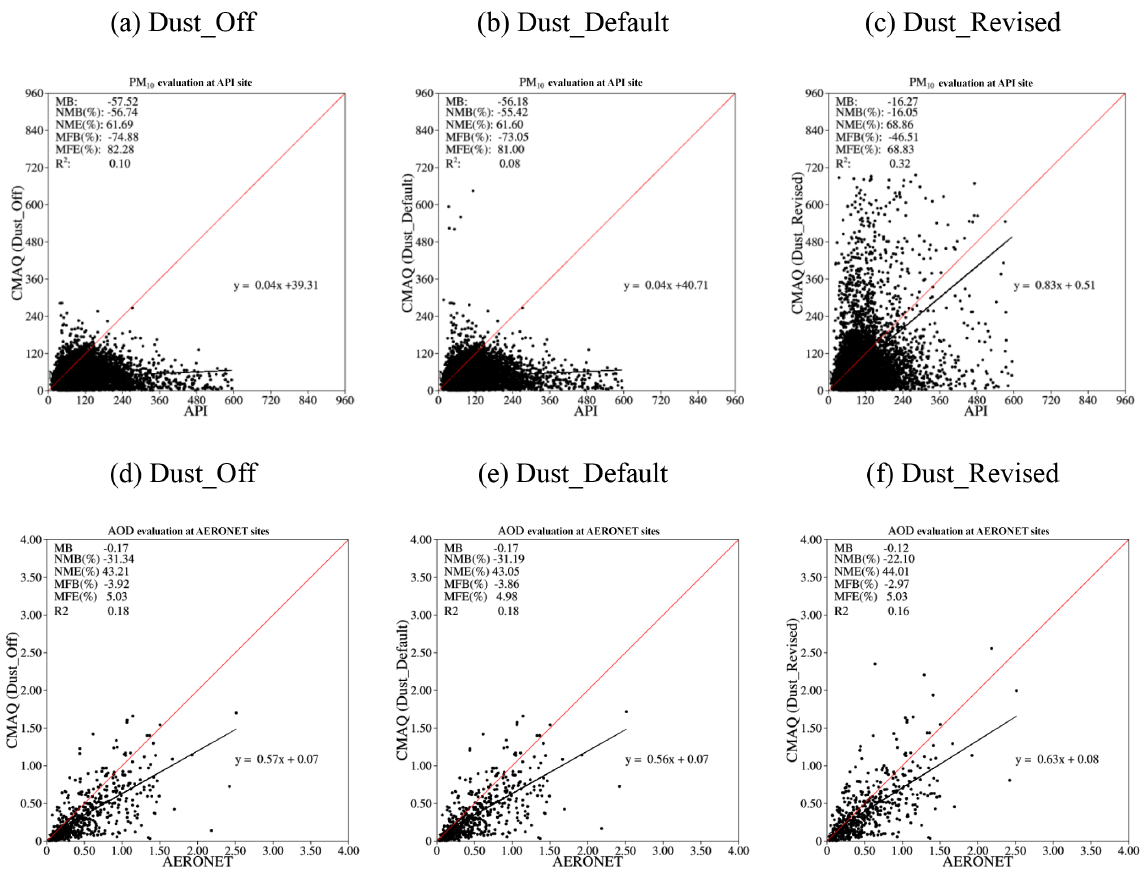
Figure 4. CMAQ evaluation against PM 10 from API (upper row) and AOD (bottom row) from AERONET for Dust_Off (left column), Dust_Default (middle column), and Dust_Revised (right column) scenarios. The formula for calculating evaluation statistics, including mean bias (MB), normalized mean bias (NMB), normalized mean error (NME), mean fractional bias (MFB), mean fractional error (MFE), and correlation coefficient ( R ), can be found in Dong et al.